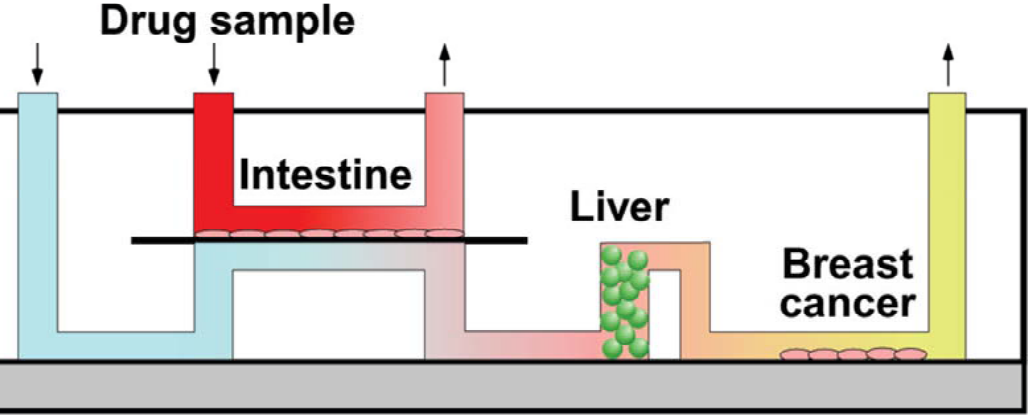
Figure 6. Multiorgan ‐ on ‐ chip to mimic metastasis. Caco ‐ 2 cells for the intestine, HepG2 cells for the liver, and MCF ‐ 7 cells for breast cancer were cultured [165], Copyright 2010, American Chemical Society.